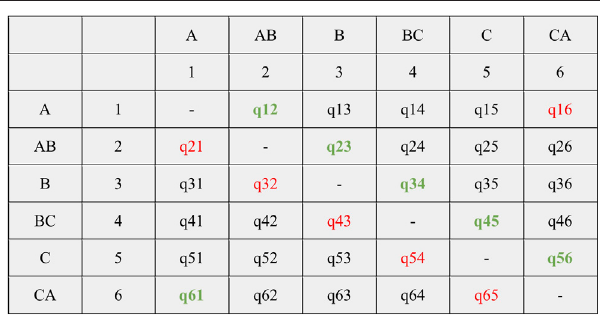
FIGURE 1 | Q matrix of the six states negative existential constructions may bein.Type-Ahasbeencodedas1,ABas2,Bas3,BCas4,Cas5,and CA as 6. The fi rst number refers to the state that is left (rows), and the second number refers to the state that is entered (columns). Thus qij is the transition parameter from Type-i to Type-j (example: q12 is Type-A > AB; q21 is Type AB > A, etc). The changes between the states described by Croft ’ s (1991)NegativeExistentialCyclehavebeenmarkedin greencolor .Thesetof opposite transitions is marked in red color . Note that, with the exception of q61 and q16, changes from smaller to bigger numbers (for example, q25; Type-AB > C) designate changes in line with the direction of the NEC, while changes from bigger to smaller numbers (for example, q52; Type C > AB) go against the direction of the